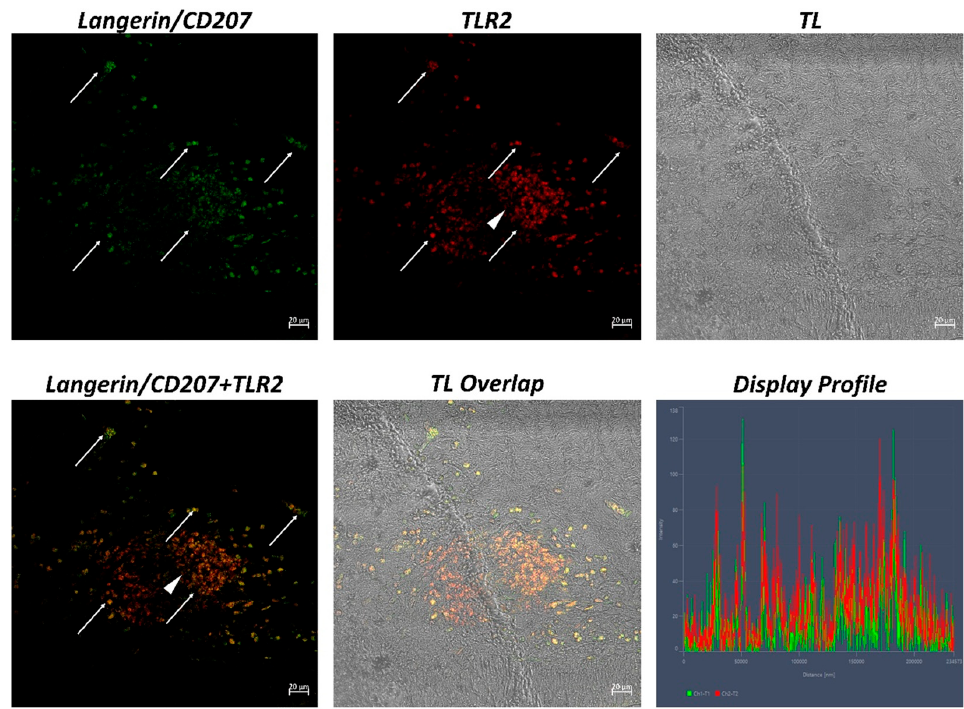
Figure 2. Section of the H. niloticus gut (immunofluorescence 20 × , scale bar 20 µ m). DC-like cells that are immunoreactive for Langerin and TLR2, organized in clusters, can be seen (arrows). Some immune cells are positive exclusively for TLR2 (see the arrowhead). The “Display profile” function highlights the colocalization. TL = transmitted light.